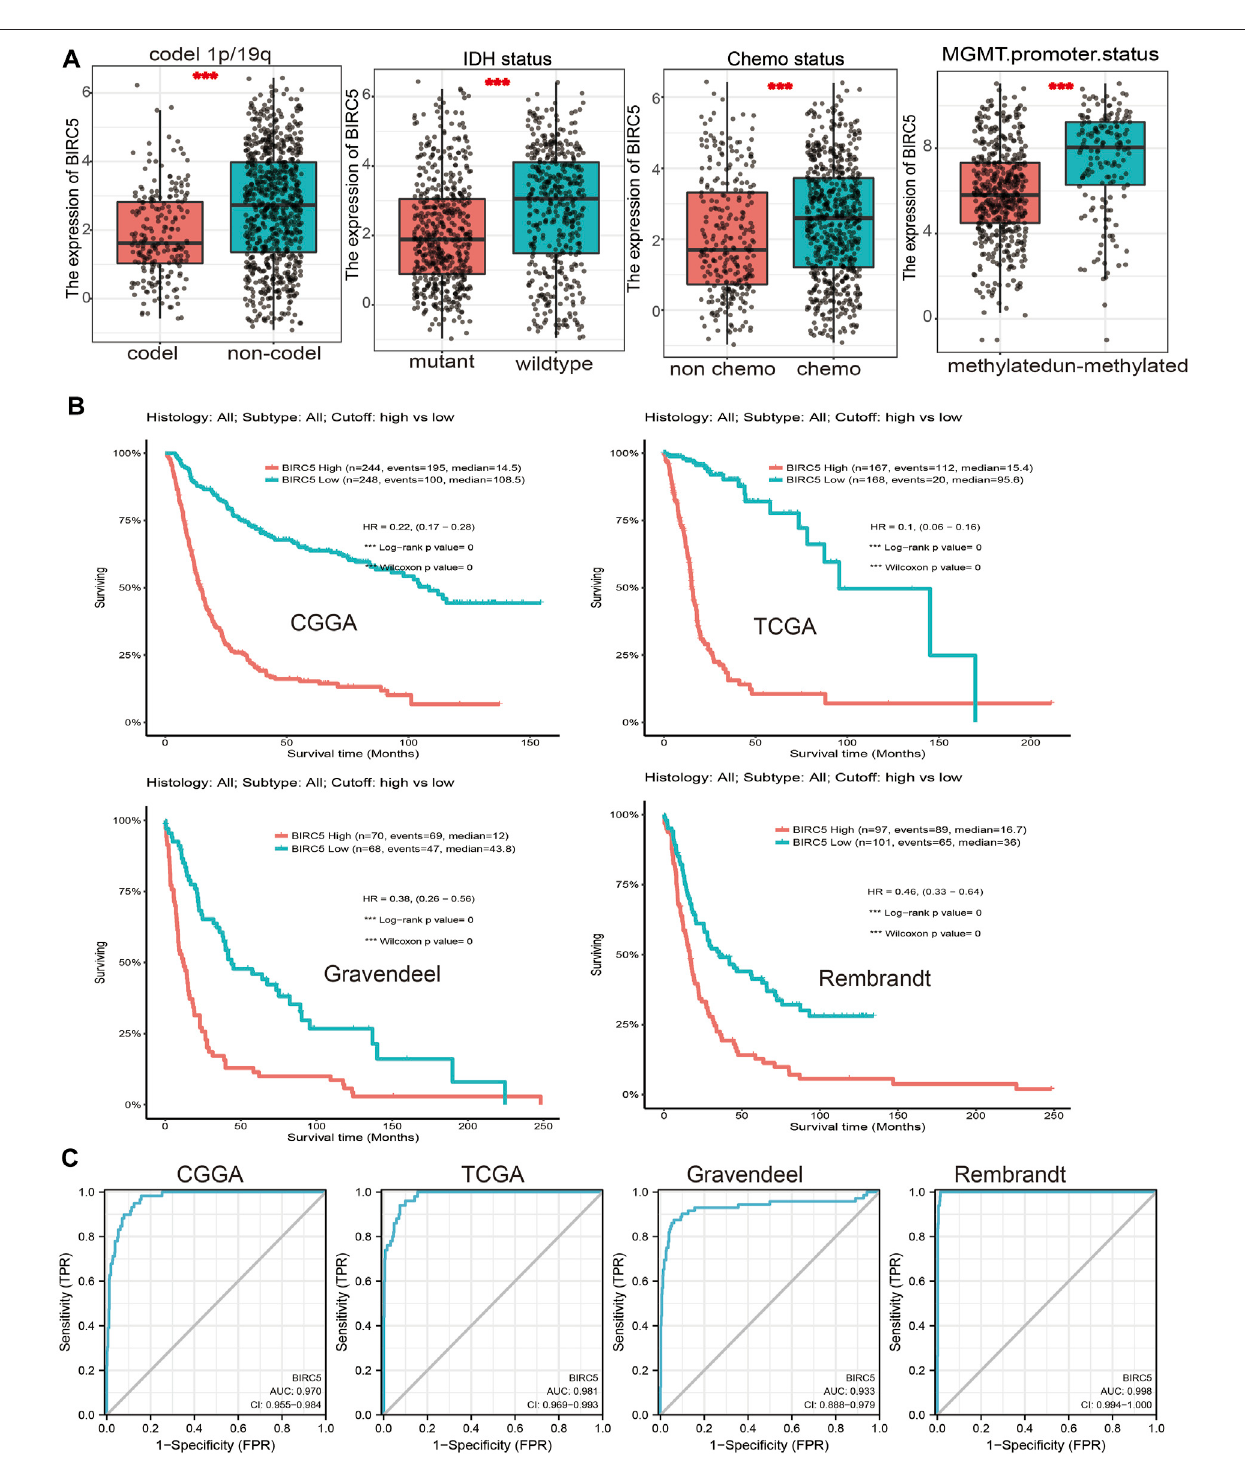
FIGURE 3 | Correlation between the BIRC5 expression and clinical information in LGG. (A) The expression of BIRC5 in diverse clinical information of glioma based onCGGAdatabases. (B) Theoverallsurvivalbetweenthehigh- BIRC5 andlow- BIRC5 inTCGA,CGGA,Rembrandt,andGravendeeldatabases. (C) Diagnosticef fi cacy of the ROC curve of BIRC5 expression in TCGA-LGG, CGGA, and TCGA-GBM.